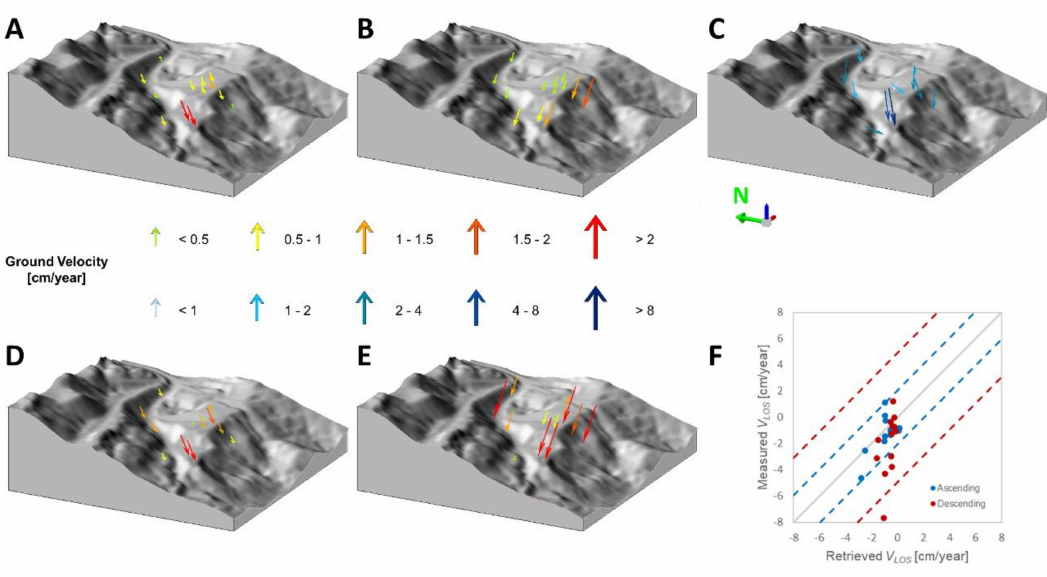
Figure 4. Results of the validation analysis. A 3D view of the ( A ) InSAR ascending and ( B ) descending LOS ground velocities over the points monitored by DGPS, ( C ) raw DGPS ground velocities for the period from 11 July 2017 to 15 November 2018, and DGPS ground velocities projected onto the ( D ) ascending and ( E ) descending LOS. ( F ) Scatter plot of the LOS ground velocities V LOS measured by DGPS and retrieved by InSAR. The gray solid line indicates the cases where the retrieved and the measured LOS ground velocities V LOS are exactly equal. The blue (red) dashed lines denote the 95% confidence band for the ascending (descending) data (i.e., two times the RMSE).